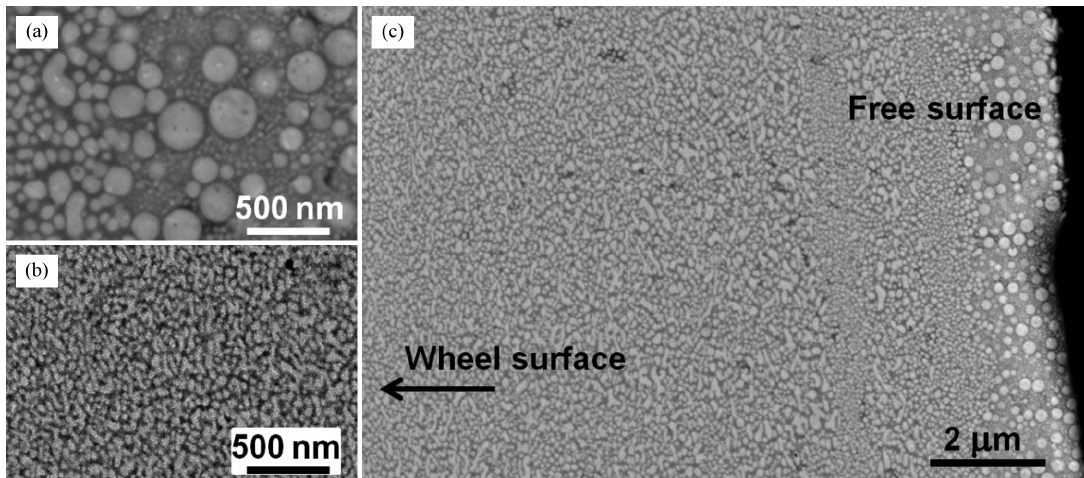
Figure 3. SEM image of the melt-spun Ag The ribbon ejection temperature was 1273 K.